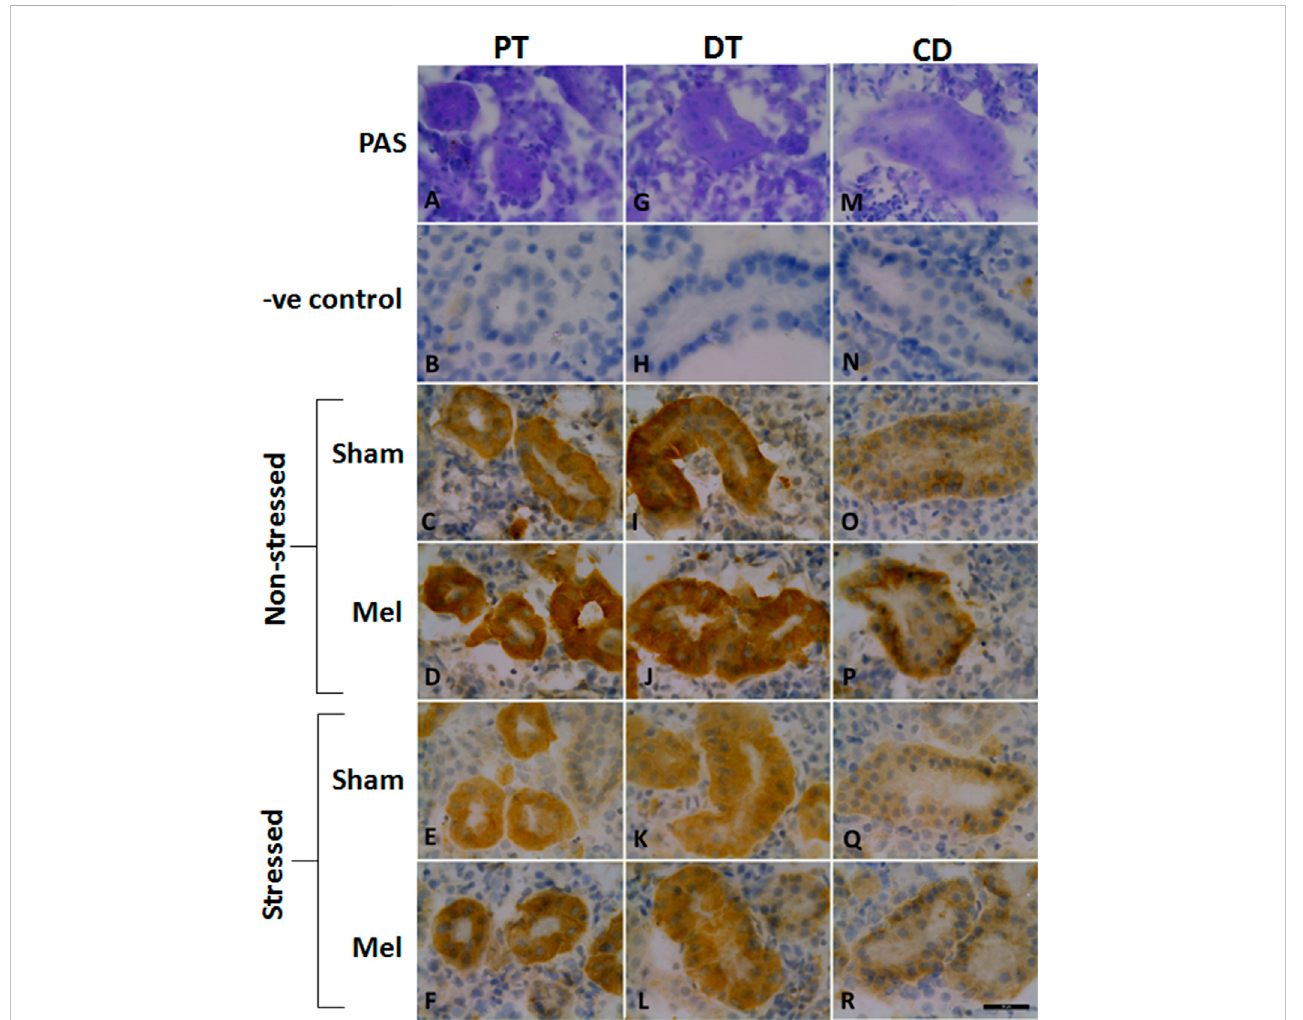
FIGURE 8 Representative immunohistochemical images of the proximal kidney tubules (A – F) , distal kidney tubules (G – L) and collecting ducts (M – R) of climbing perch showing renal ionocytes in melatonin (Mel) treated or immersion-stressed (IMR) or both. Adjacent cryostat sections were stained with Periodic acid- Schiff-hematoxylin stainfor distinguishing the different segments of tubules (A,G,M) and laterimmunostained with anti-Na + /K + ATPase α -antibody. Imagesof non-stressed fi shcontrol (C,I,O) ,melatonin[50 ng g − 1 ; (D,J,P) ]andimmersion-stressed fi shcontrol (E,K,Q) .Melatoninwasgiventoimmersionstressed fi sh (F,L,R) . Negative controls were kept under the same conditions without primary antibody that yielded no immunoreactivity (B,H,N) . Scale bar = 20 μ